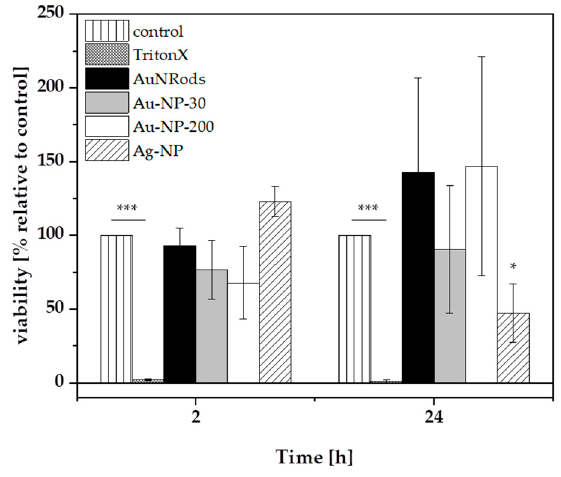
Figure 7. Cell viability of the gastrointestinal in vitro model after 2 h and 24 h incubation with mNPs . The in vitro model was exposed to 1 µg/mL AuNRods, AuNP-30, AuNP-200 and 30 µg/mL AgNP. Afterwards, the cell viability of the apical cell layer (Caco-2 and HT29-MTX) was analyzed via alamarBlue ® assay. n = 3, * p ≤ 0.5, *** p ≤ 0.001.